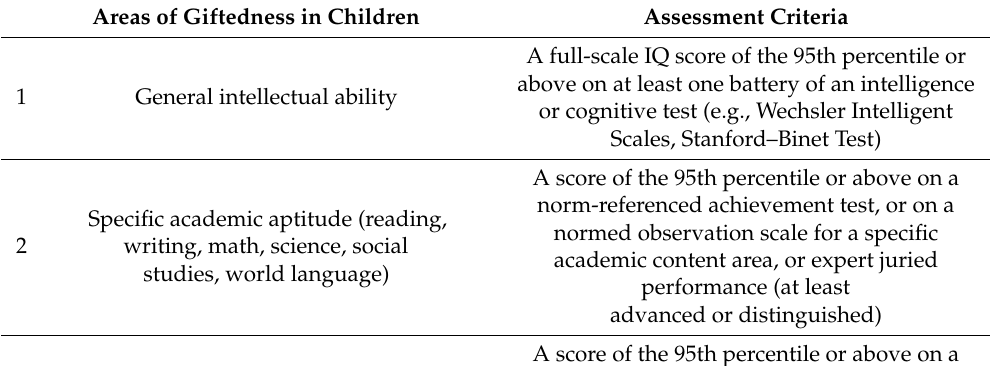
Table 1. Areas of giftedness in